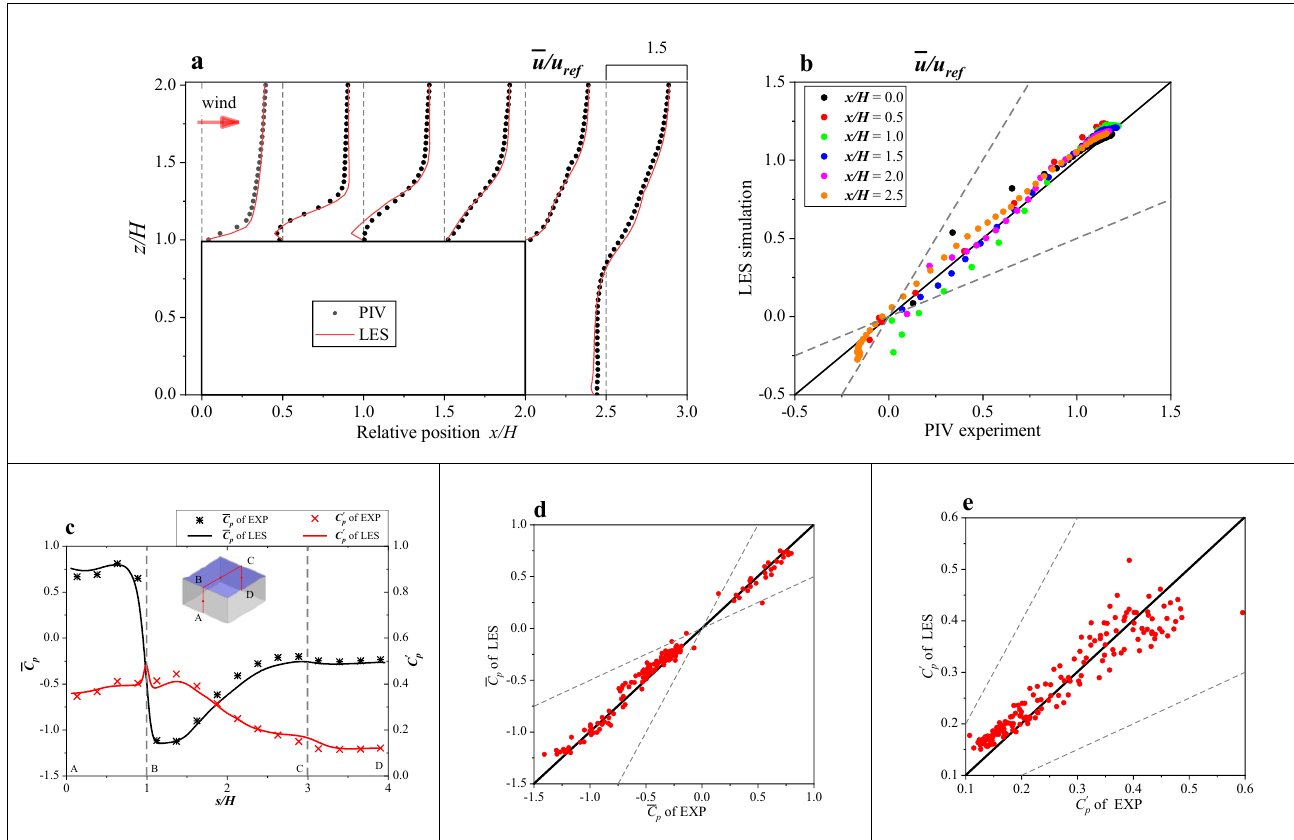
Figure 8. Comparison of the streamwise mean velocity ( 𝑢̅/𝑢 𝑟𝑒𝑓 ) and wind pressure coefficient ( 𝐶̅ 𝑃 𝑜𝑟 𝐶 𝑃′ ) between the wind tunnel experiments and LES simulation (( a , b ) Quantitative comparison for 𝑢̅/𝑢 𝑟𝑒𝑓 ; ( c – e ) Quantitative comparison for 𝐶̅ 𝑃 and 𝐶 𝑃′ ).